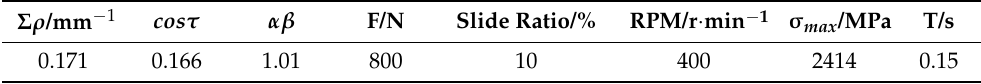
Figure 2. Schematic diagram of the rolling – sliding wear tester. Table 3. Test parameters and calculation results of contact